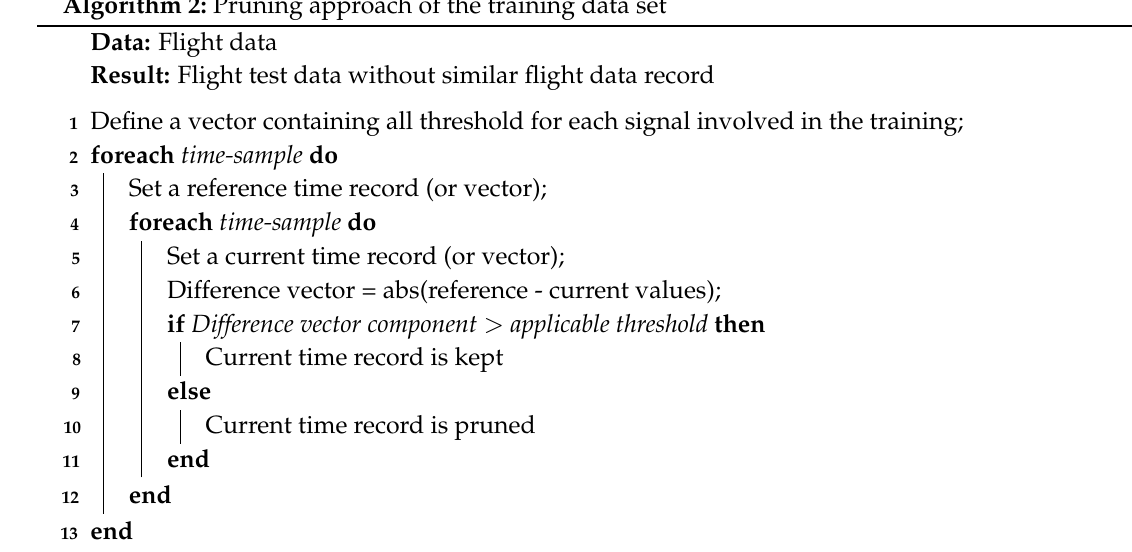
Algorithm 2: Pruning approach of the training data set Data: Flight